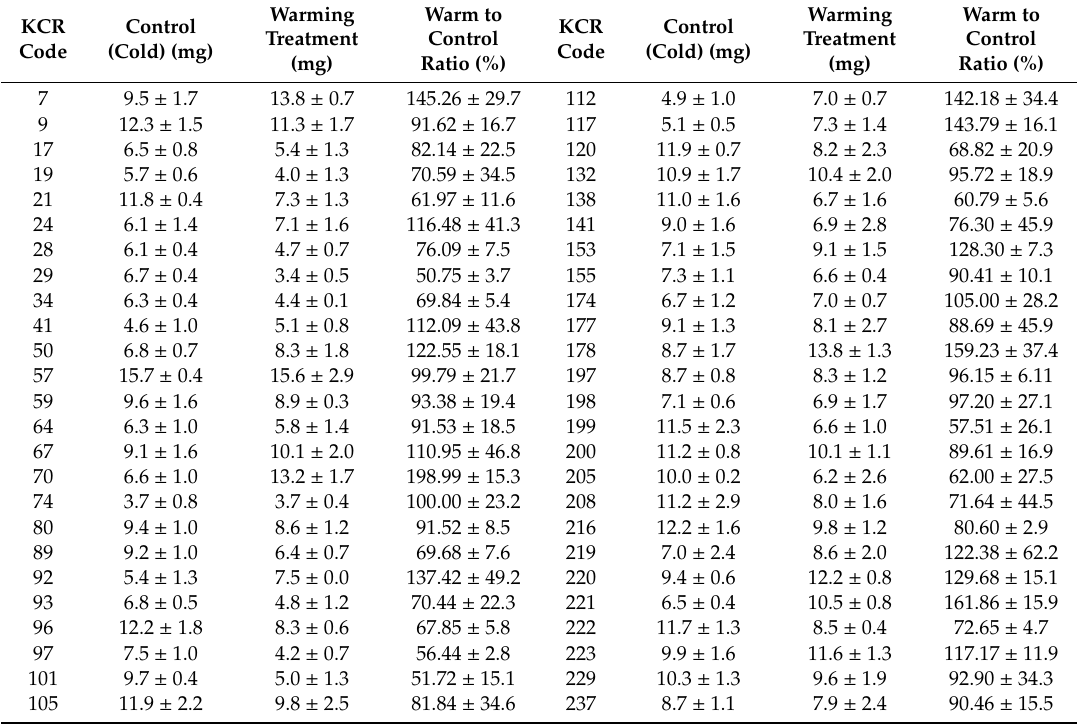
Table 8. Root dry weight of varieties under the control (cold) condition and warming treatment. KCR